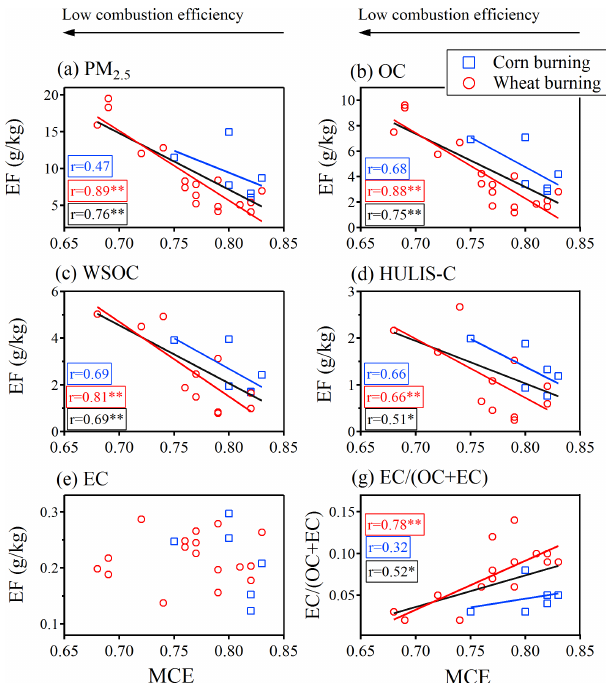
Figure 3. Emission factors of PM 2 . 5 , carbonaceous aerosols (OC, WSOC, HULIS C and EC) and EC /( OC + EC ) ratios as a function of modified combustion efficiency (MCE). Corn and wheat burning emissions are denoted by red and blue colors, respectively. The r values in each panel are the Pearson correlations between emission factors and MCE for corn (blue), wheat (red) and the overall (black) burning experiments. The ∗∗ or ∗ following the r value indicates the correlation is significant at the 0.01 level or 0.05 level